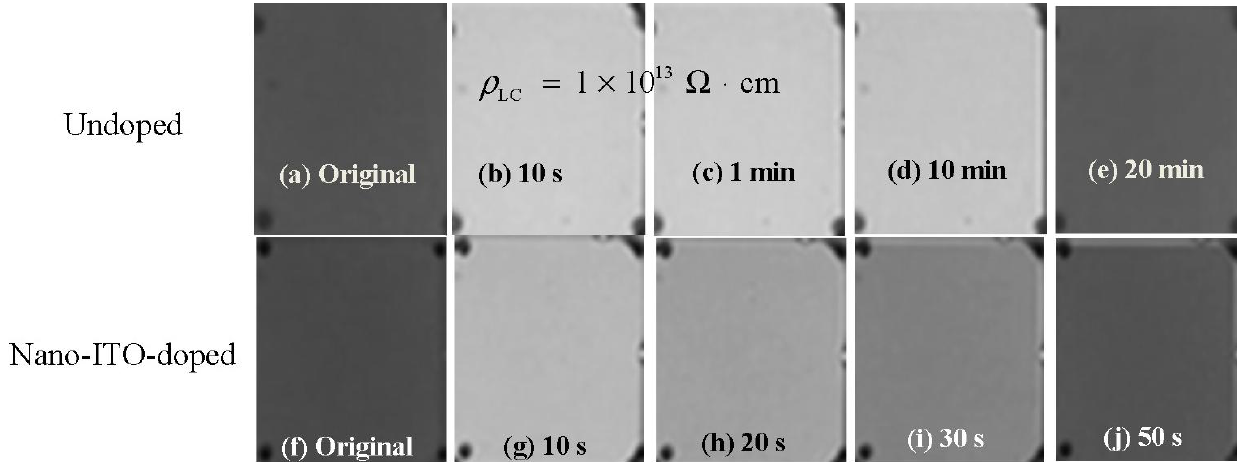
Figure 11. Relaxation of the sticking images after an ESD attack by 8 kV stimulus for the LC samples of 1 × 10 13 Ω∙cm. In the tests, the cells were designed in the normally black mode. The time elapse from when the photograph was taken is also marked on each